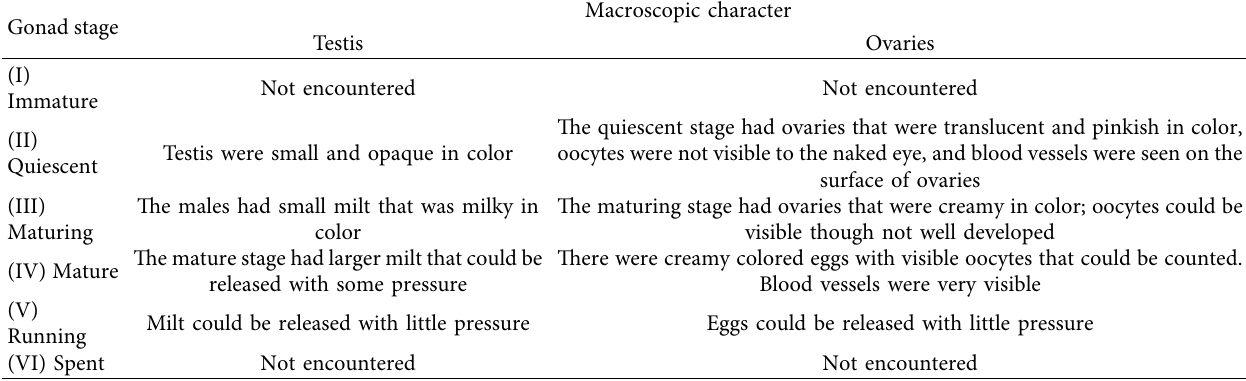
Table 5: Stages of gonad developments observed in H. niloticus .